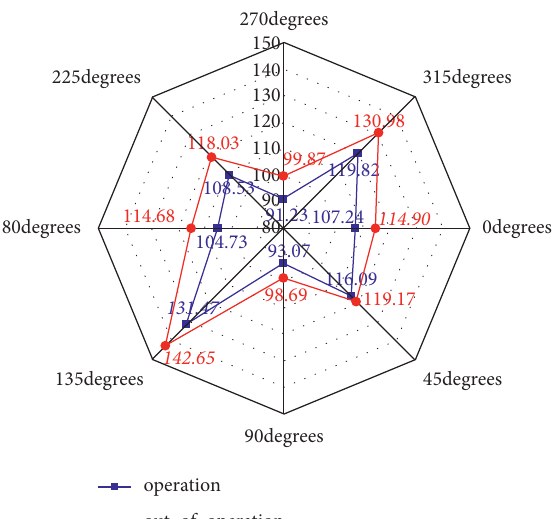
Figure 11: Maximum stress of lattice columns under different orientations of the tower arm in operation condition and out-of-operation condition (mm).